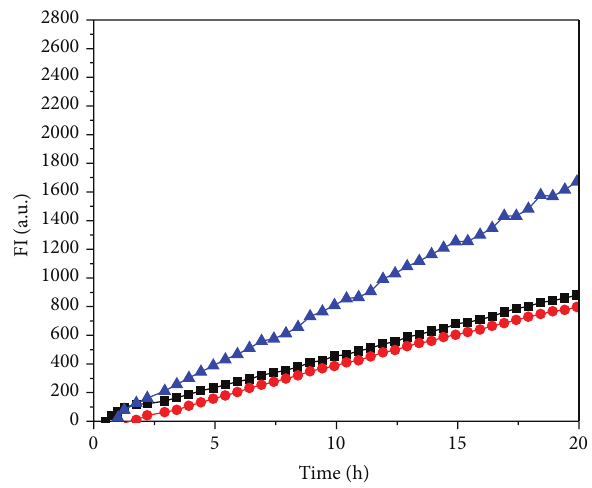
Figure 7: Effect of heat treatment on the SMase activity of C. pneumoniae . Bacteria were incubated for 5min at either 60 ( ◼ ) or 90 ∘ C ( e ), and bacteria maintained at 37 ∘ C were used as a control ( 󳵳 ). Amplex Red assays were started by adding 1 × 10 7 IFUs of bacteriaandincubatedinatotalvolumeof200 𝜇 Lat37 ∘ C.Resorufin fluorescence FI a.u. (fluorescence intensity, arbitrary units) was